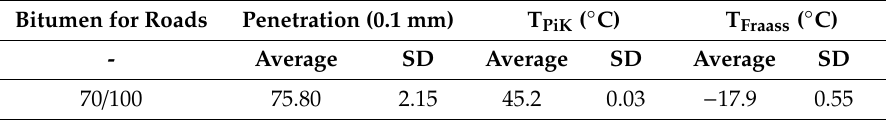
Table 1. Results of the tests of the properties of the 70 / 100 bituminous